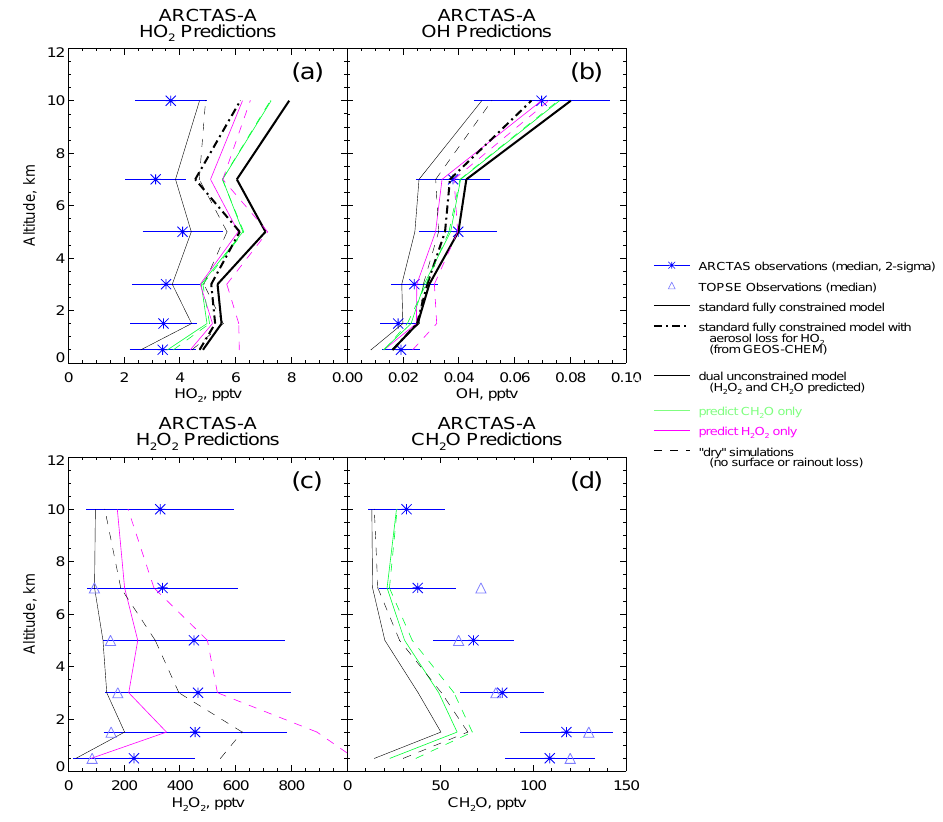
Fig. 18. Altitude profiles for observations and model predictions of (a) HO 2 , (b) OH, (c) H 2 O 2 and (d) CH 2 O during ARCTAS-A, with model predictions from several different permutations of the LaRC box model. Asterisks show the median observations, and the associated horizontal blue lines indicate the 2 σ uncertainty in the observation. Median observations of H 2 O 2 and CH 2 O from TOPSE-sp are shown with triangles in (c) and (d)